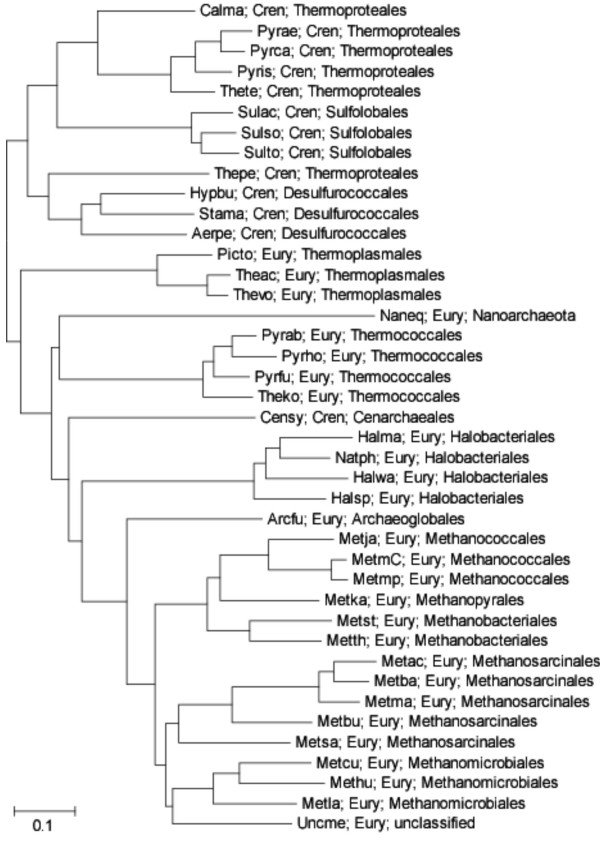
The gene-content tree of archaea constructed on the basis of the phyletic patterns of arCOGs. The species abbreviations are as in Table 1. Cren, Crenarchaeota; Eury, Euryarchaeota.